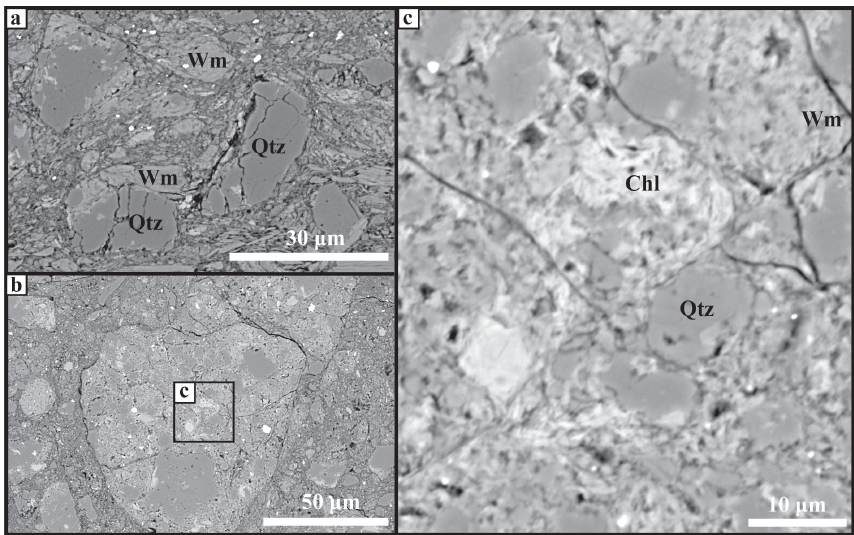
Figure 8. Scanning electron images collected from sample DFDP 1B 69_2.48 showing the existing mineral associations. (a) Subrounded and intensely fractured quartz and white mica clasts, within fine matrix material. (b) Reworked cataclasite clasts in phyllosilicate-rich matrix. (c) Fine chlorite and white mica aggregates between quartz clasts. (Qtz: quartz; Wm: white mica; Chl: